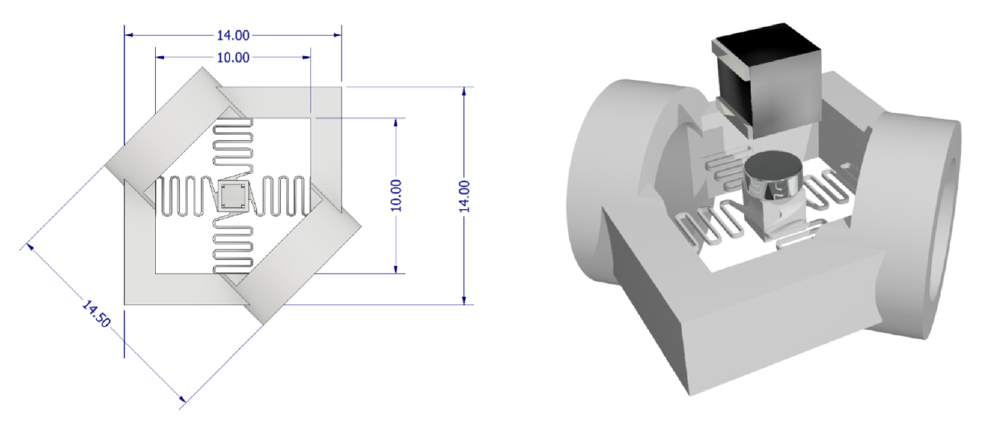
Figure 4. ( left ) Top view of inkjet printed harvester with dimensions in mm [44], ( right ) harvester with magnet and coil